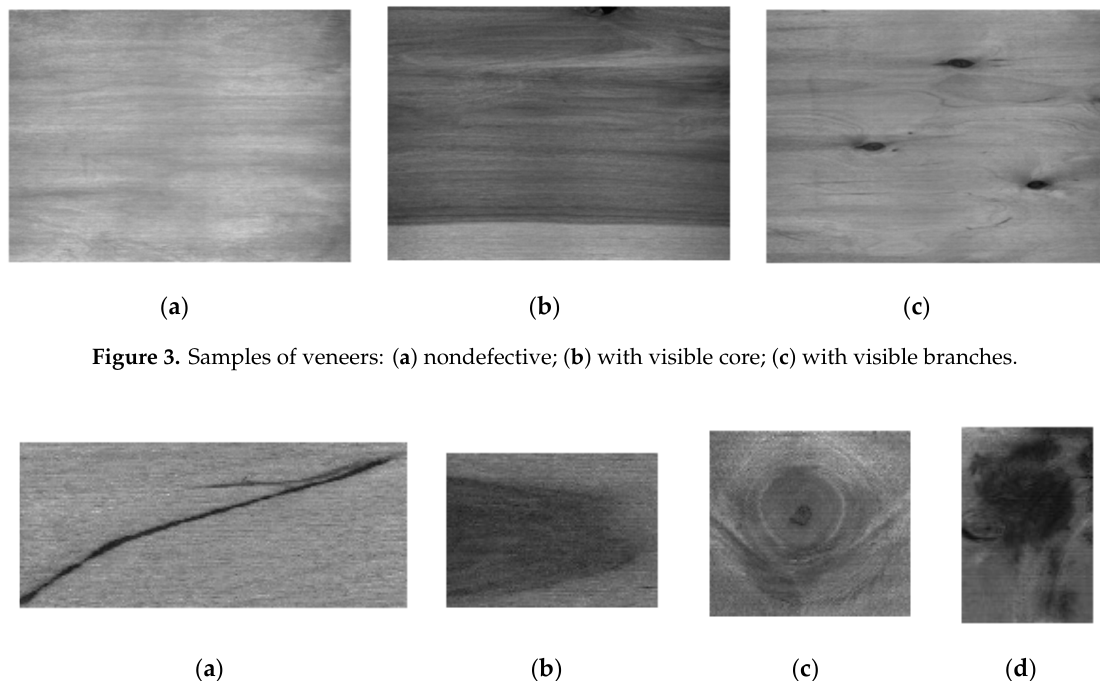
Figure 4. Examples of wood veneer defects: ( a ) split; ( b ) core; ( c ) branch; ( d ) stain.